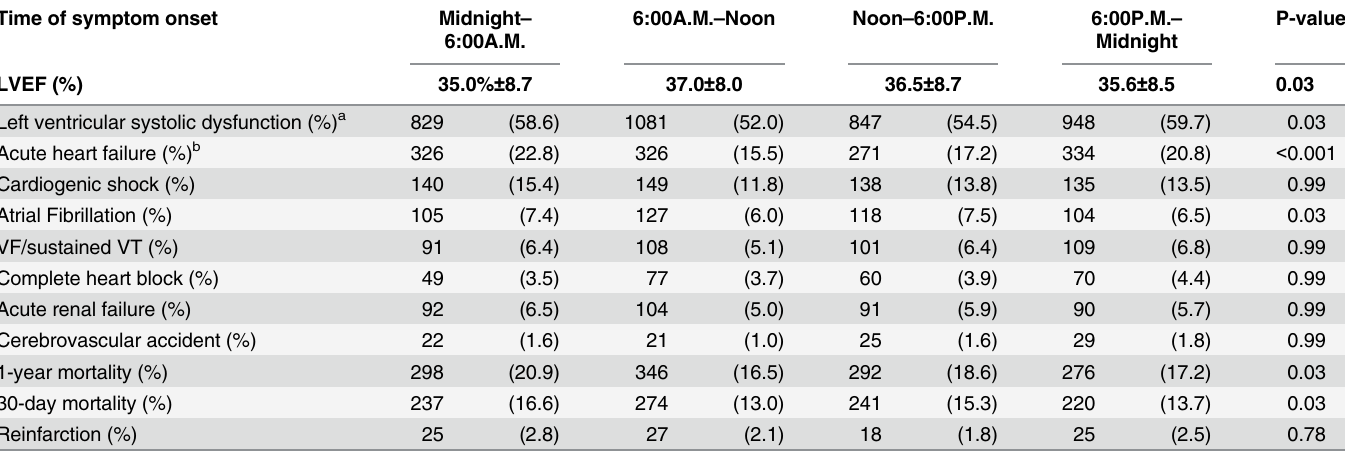
Short- and long-term clinical outcomes categorized according to time of symptom onset.